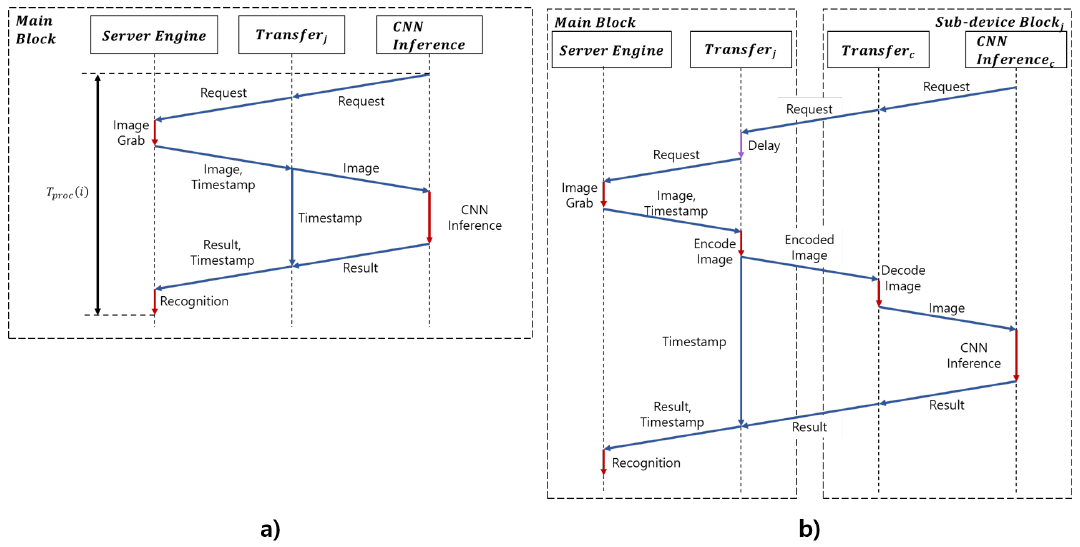
Figure 11. ( a ) Procedure in the main block. ( b ) Procedure between the main and sub-device